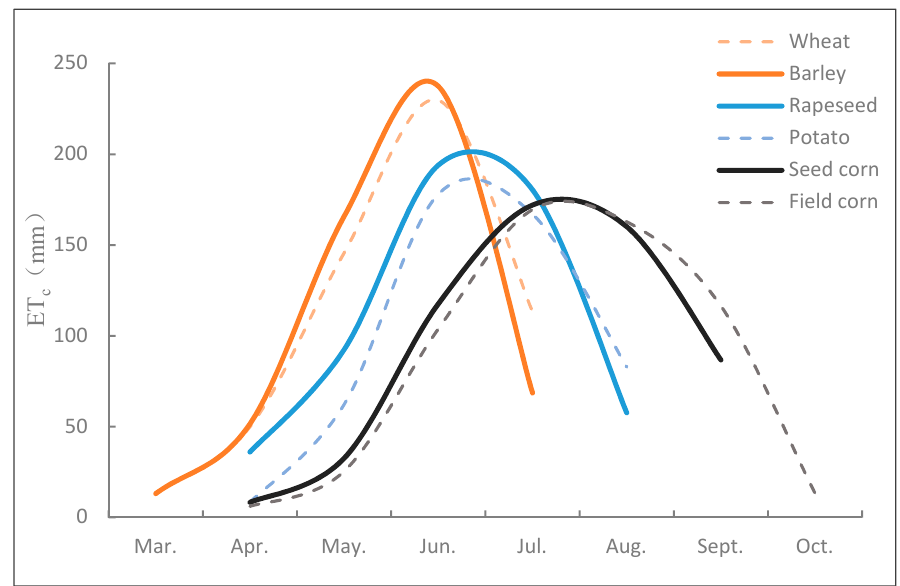
Figure 3. ET c of the crop growth period.